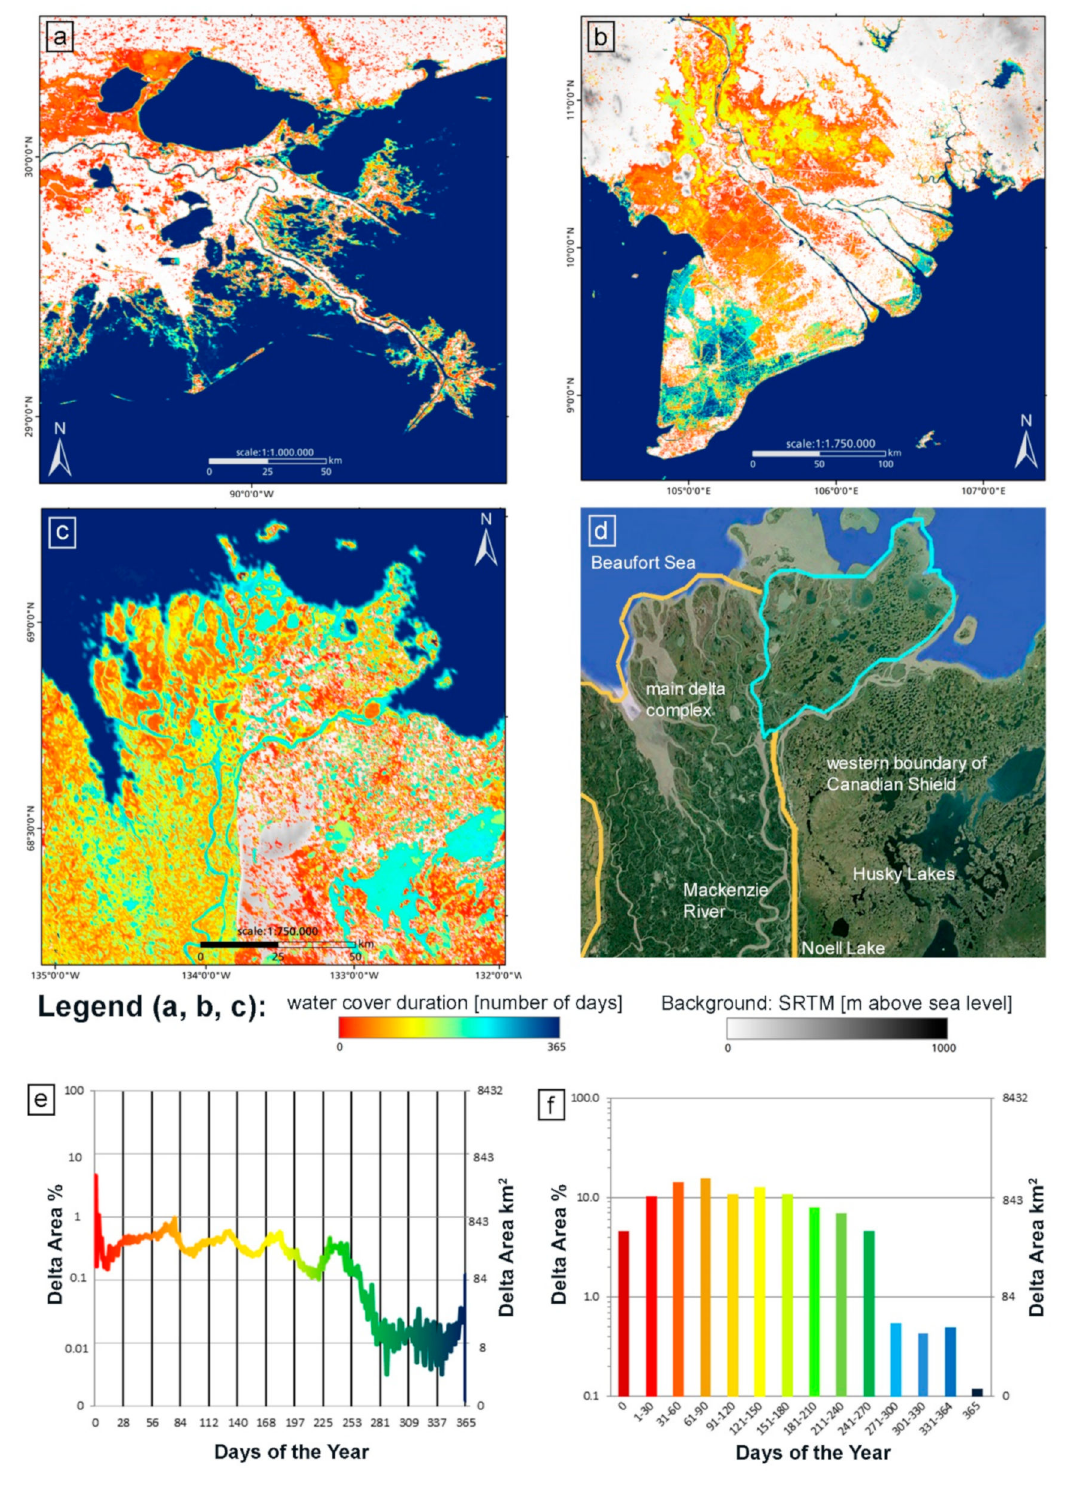
Figure 6. Intra-annual inundation patterns (2013) in the Mississippi Delta, USA ( a ) and the Mekong Delta, Vietnam ( b ), and intra-annual (2013) water cover dynamics of the Mackenzie Delta region showing a water cover duration map ( c ), location and true color satellite image ( d ), and quantitative analyses of inundation dynamics at daily ( e ) and monthly ( f ) intervals (Kuenzer et al.